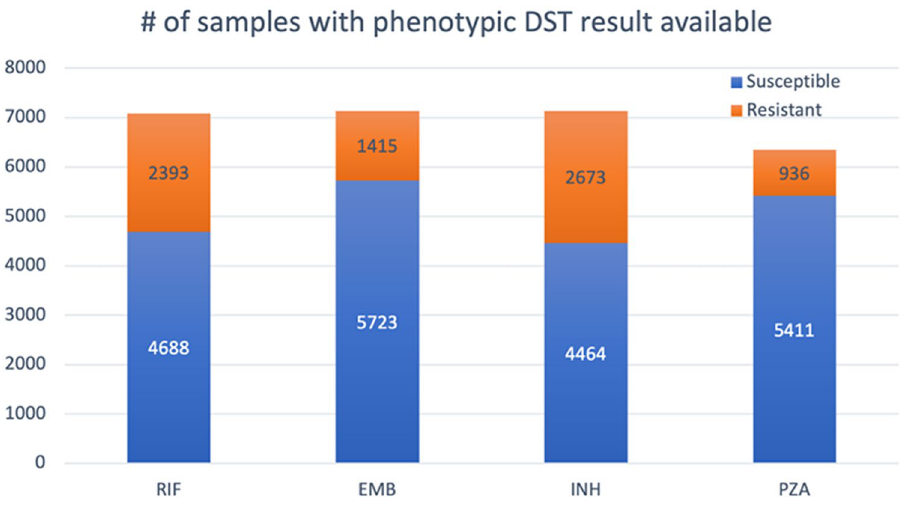
Figure 1. Phenotypic overview of the MTB isolates. This bar chart shows numbers of susceptible and resistant isolates with DST results available for each of the four first-line